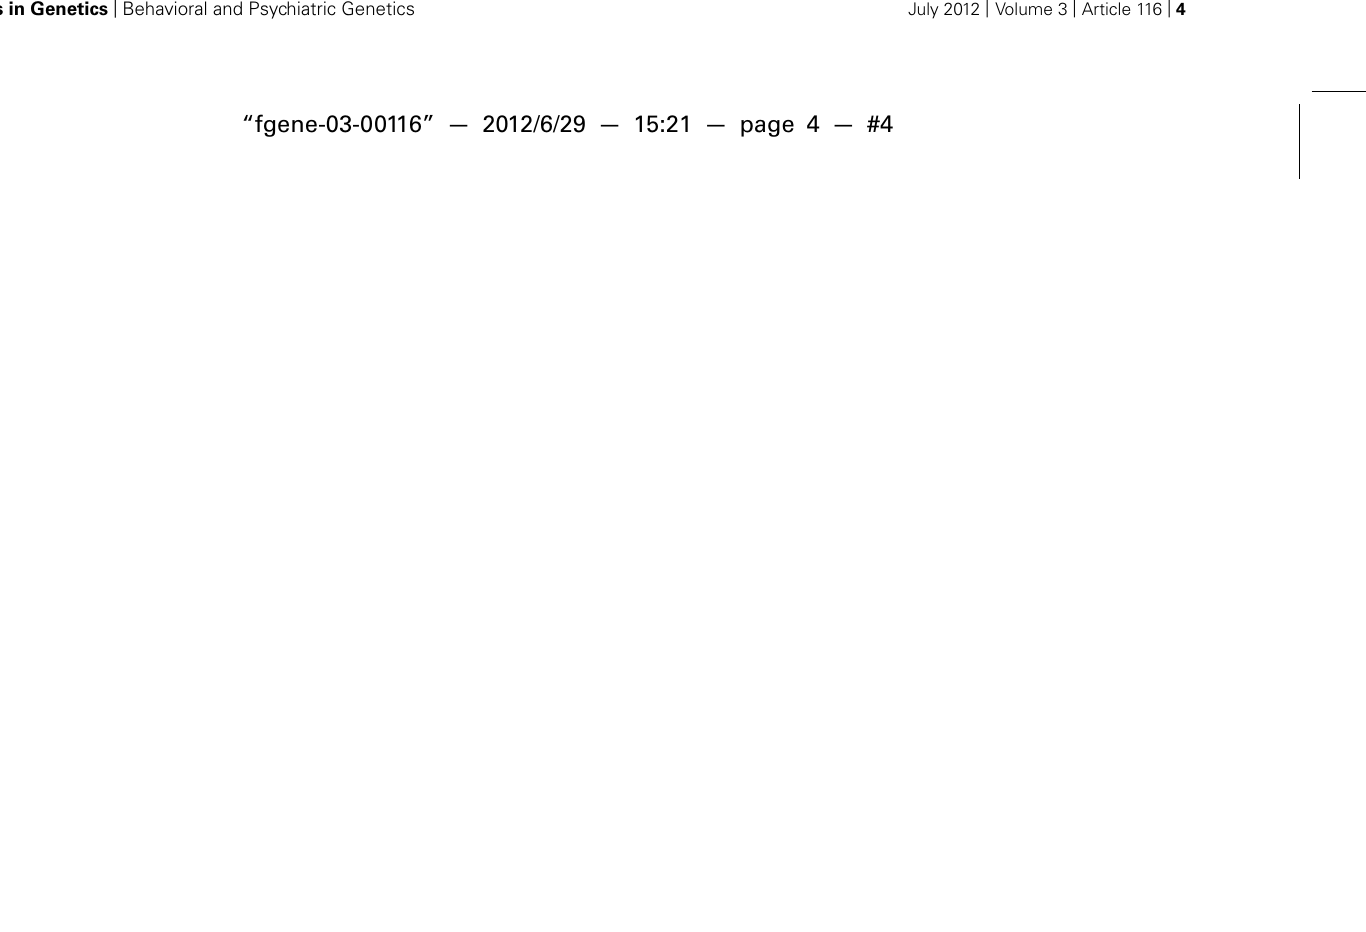
“fgene-03-00116” — 2012/6/29 — 15:21 — page 4 — #4